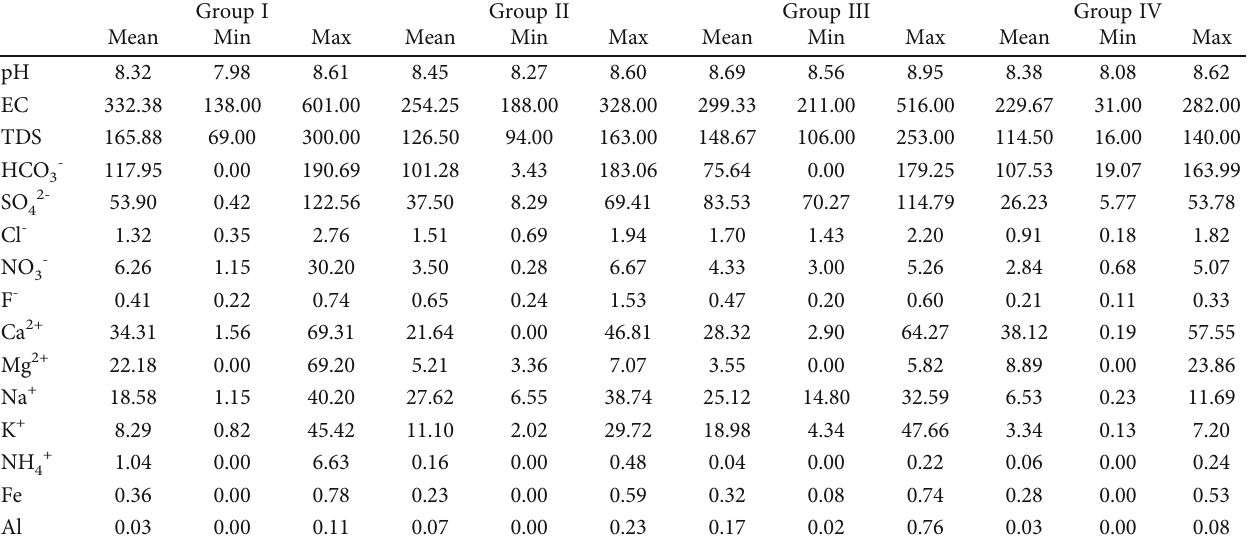
Table 5: Statistics of groundwater water chemical parameters